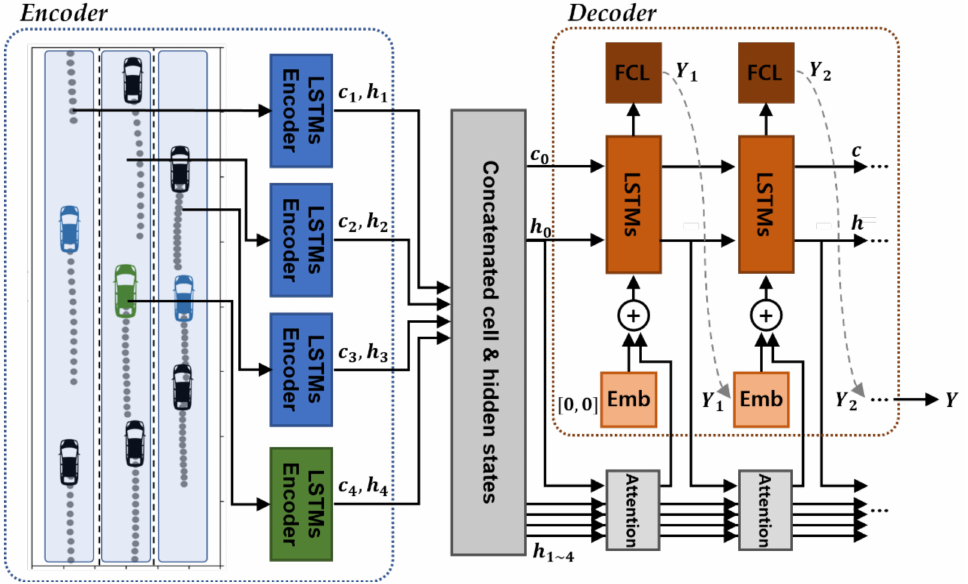
Figure 5. Lane stream attention-based LSTM encoder–decoder